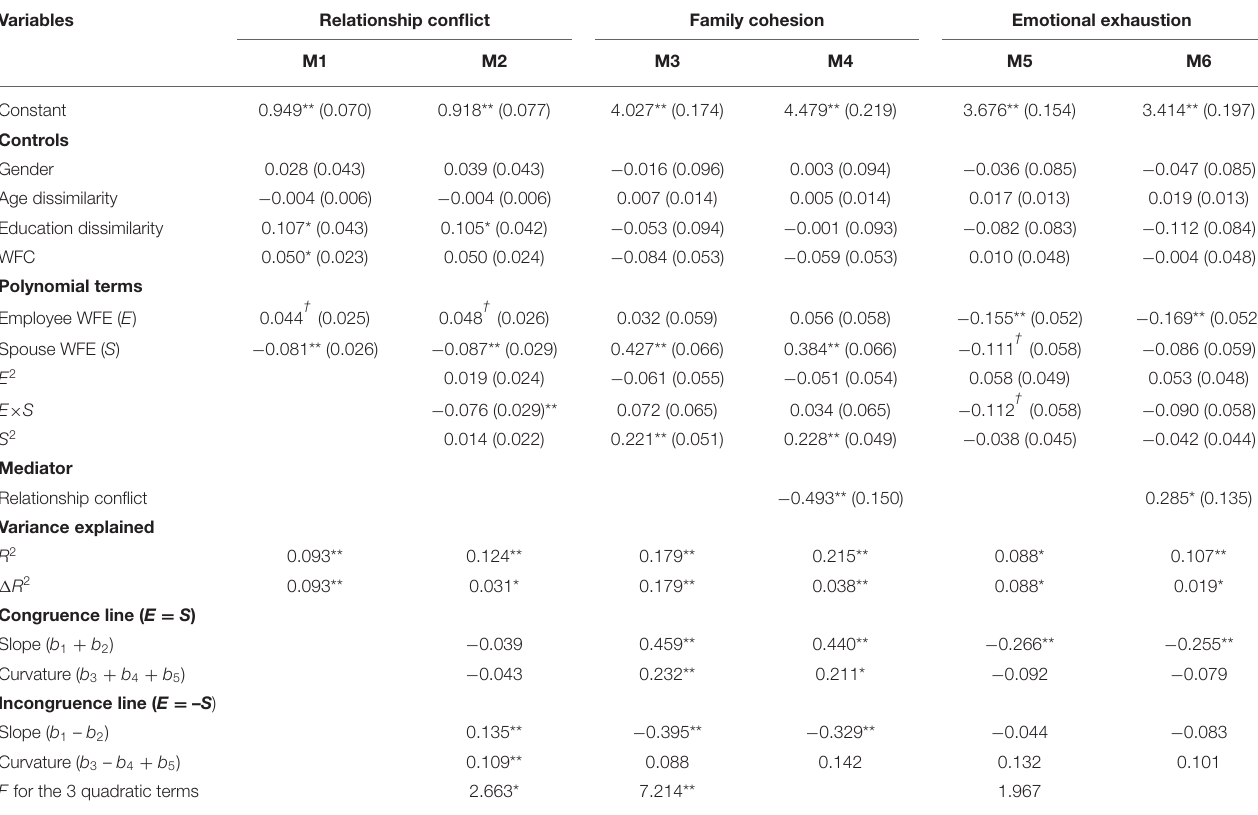
TABLE 3 | Polynomial regressions of relationship conflict, family cohesion, and emotional exhaustion on WFE congruence.